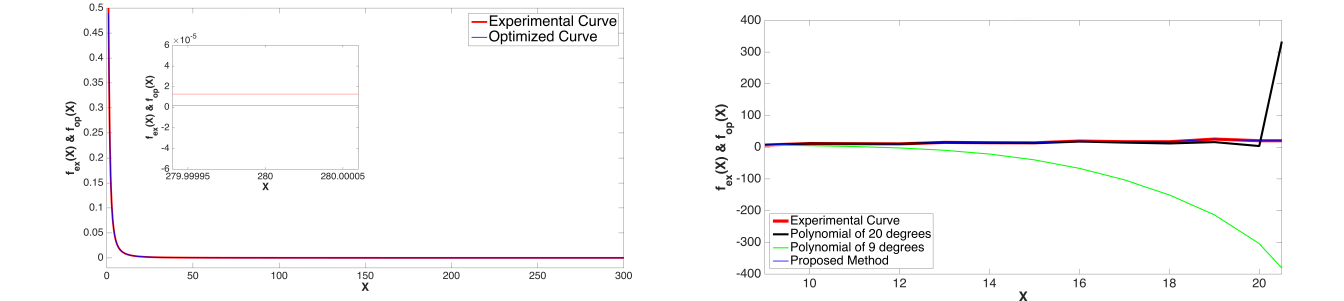
Figure 6. Extrapolation of the case study 1.